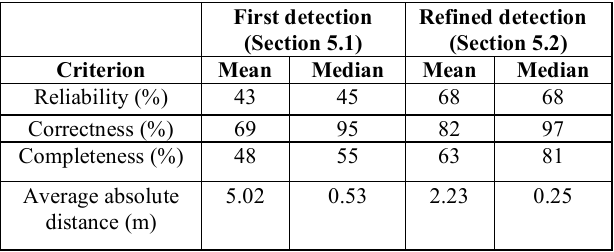
Table 2. Accuracy assessment of the plane detection.